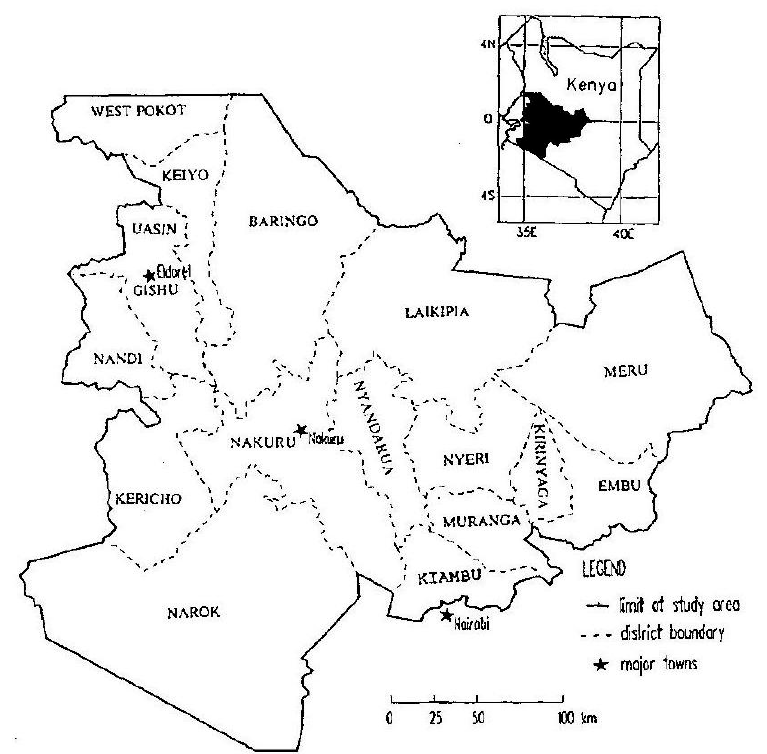
Figure 4. Map showing homelands of the Kikuyu immigrants on Kamuyu farm from Nyandarua and Nyeri (Sourced from [65]).